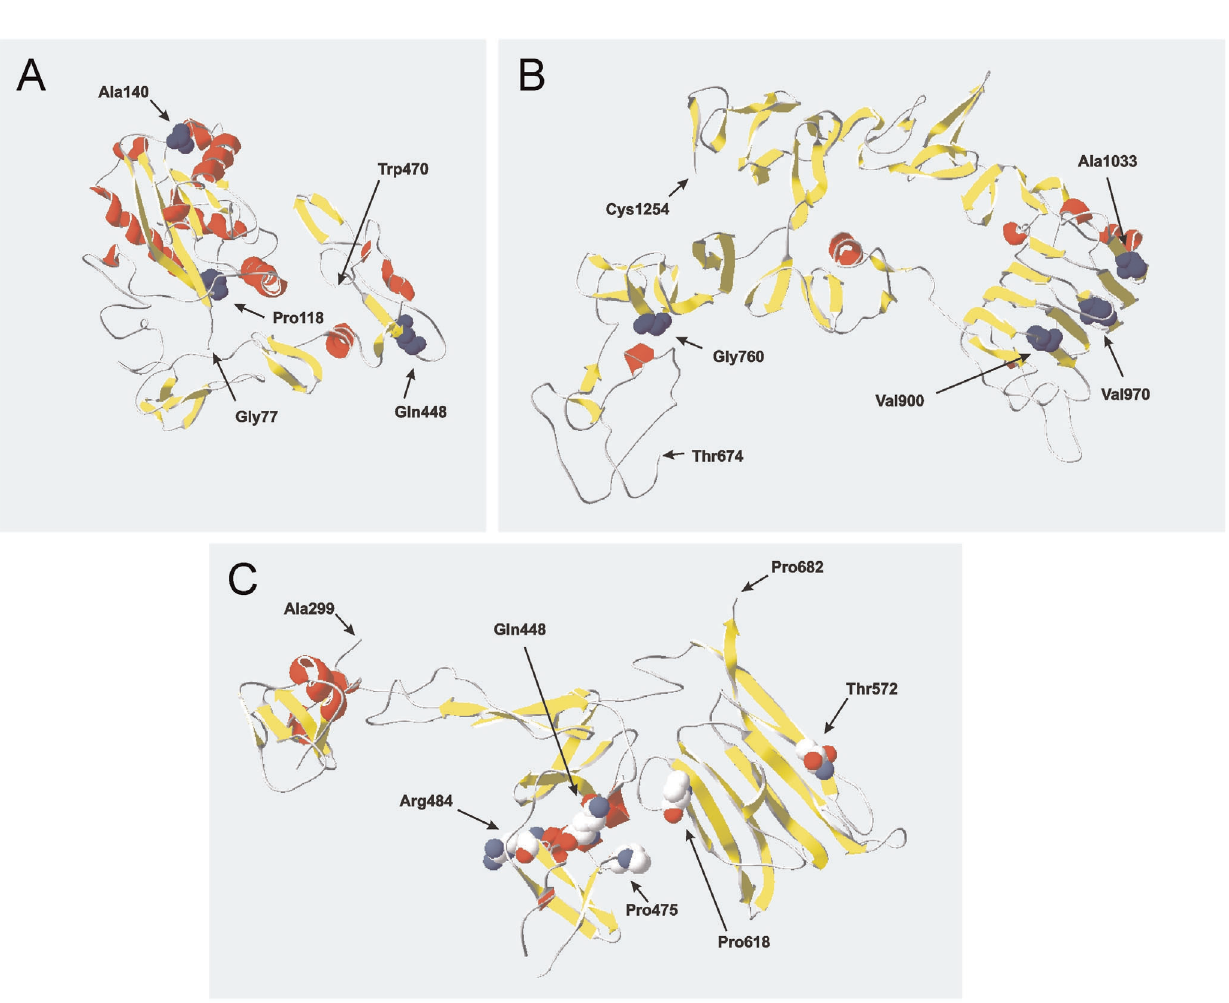
Figure 4. Ribbon diagrams of the ADAMTS13 fragments. Two upper panels: Left - comprising residues (77–470) and right (674–1254) built using comparative modeling (3D-PSSM algorithm). Bottom panel ADAMTS13 X-ray structure residues (287–682) PDB ID 3GHM. Helices are depicted in red and beta-structures are in yellow. Residues encoded by codons/variants under investigation are denoted with residue number (van der Waals’ radii of the side chains are shown). Beginning and end of each fragment are also denoted with a residue number.